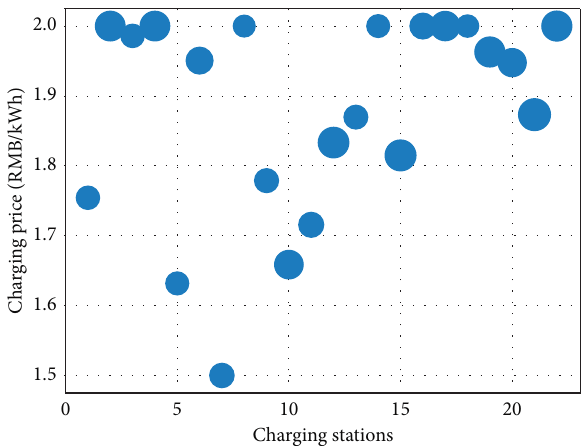
Figure 16: Charging price with